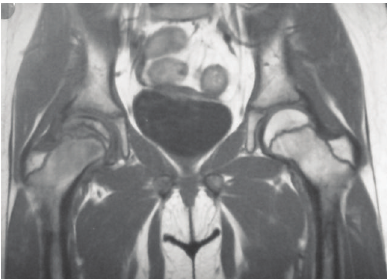
Figure 3: Flattened right femoral head, joint e ff usion, enlarged physes, bone marrow oedema of the femoral neck, and minimal sclerotic changes of the articular surface. There is a remarkable increase of the signal on T 1 W sequences only in the deep portion of the femoral head.